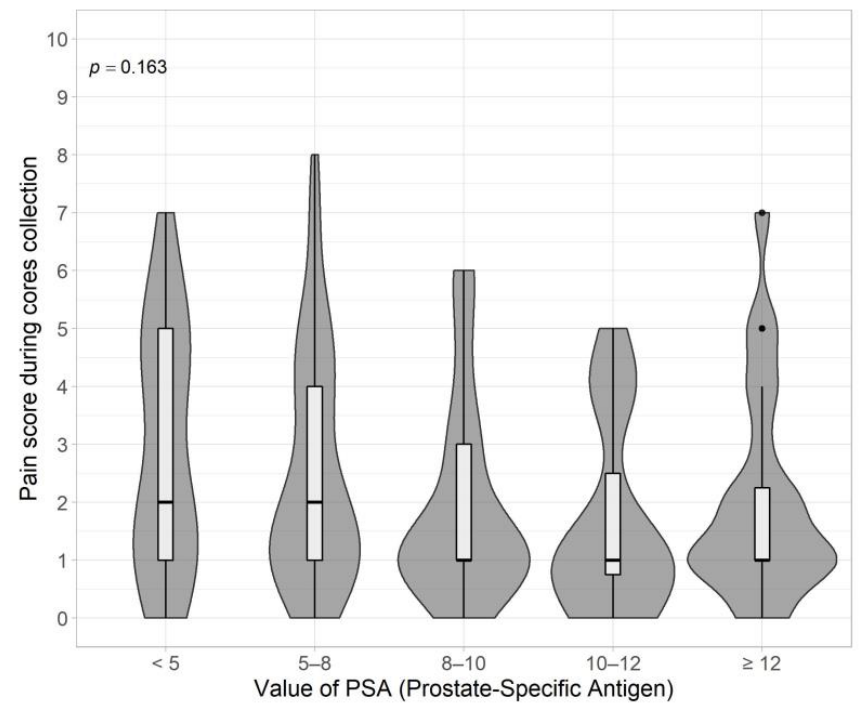
Figure 3. PSA value vs. pain experienced during biopsy. The result of the ISUP GG analysis clearly indicates statistically significant differences between patients with ISUP 0–1 and ISUP 2–5 ((IQR 1–5); p = 0.038) (Figure 4, Table 2). Patients with ISUP 2–5 more often indicate higher pain scores.